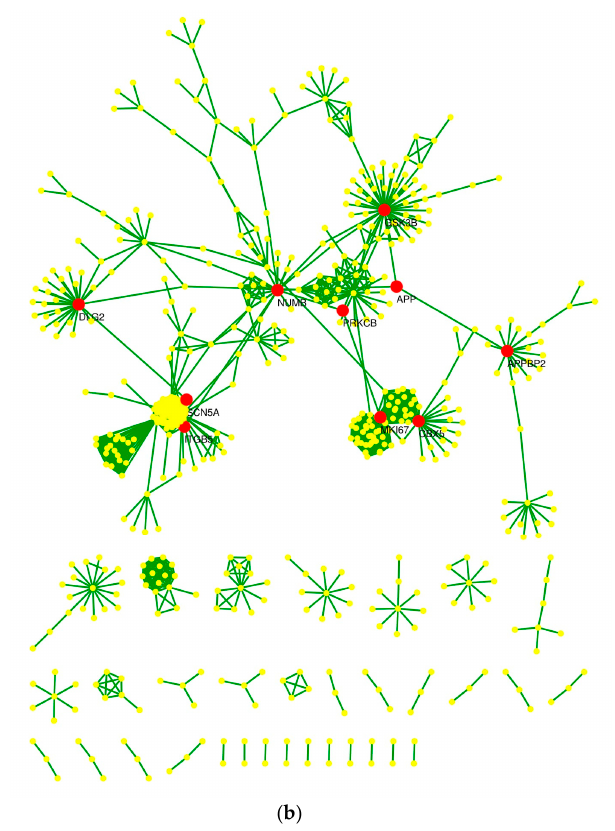
Figure 3. ( a ) Top 10 Hub nodes detected by Degree method, Top 10 hub nodes are marked with red color, which have been detected based on degree method; ( b ) Top 10 Hub nodes detected by Bottleneck method, Top 10 hub nodes are marked with red color, which have been detected based on bottleneck method.